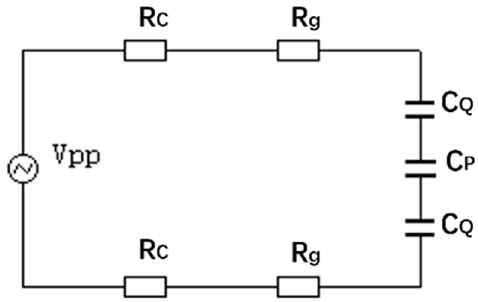
Figure 8. Equivalent circuit illustration of the graphene-based modulator.